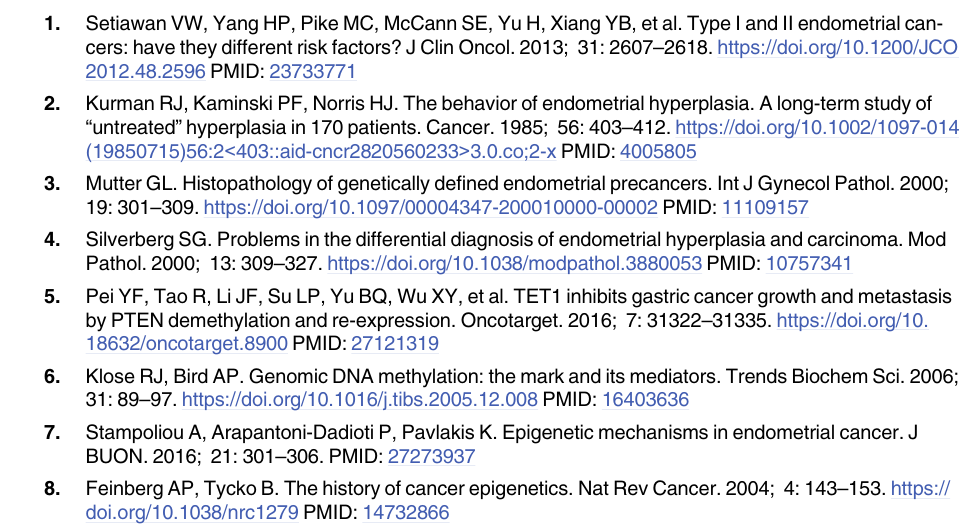
S2 Fig. Kaplan–Meier analysis stratified according to 5-hmC expression score. Analysis to assess the prognostic value of the 5-hmC immunoreactivity in relation to OS. (TIF) S3 Fig. Kaplan–Meier analysis stratified according to 5-hmC expression score. Analysis to assess the prognostic value of the 5-hmC immunoreactivity in relation to PFS. (TIF) S4 Fig. Kaplan–Meier analysis stratified according to 5-mC expression score. Analysis to assess the prognostic value of the 5-mC immunoreactivity in relation to OS. (TIF) S5 Fig. Kaplan–Meier analysis stratified according to 5-mC expression score. Analysis to assess the prognostic value of the 5-mC immunoreactivity in relation to PFS.